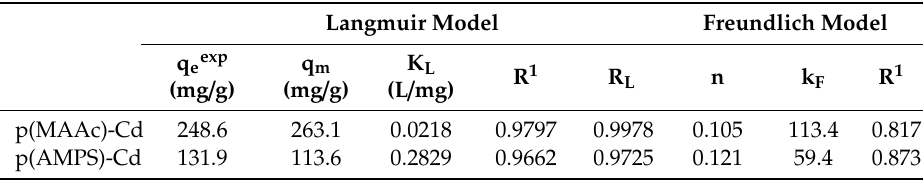
Table 3. Parameters of isotherm models for metal ions sorption by